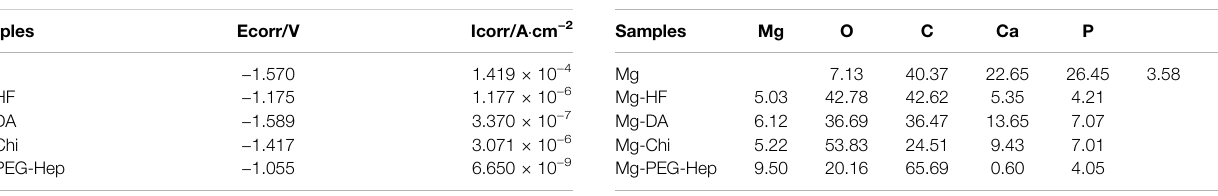
TABLE 2 | Corrosion potential and corrosion current densities of the different samples.